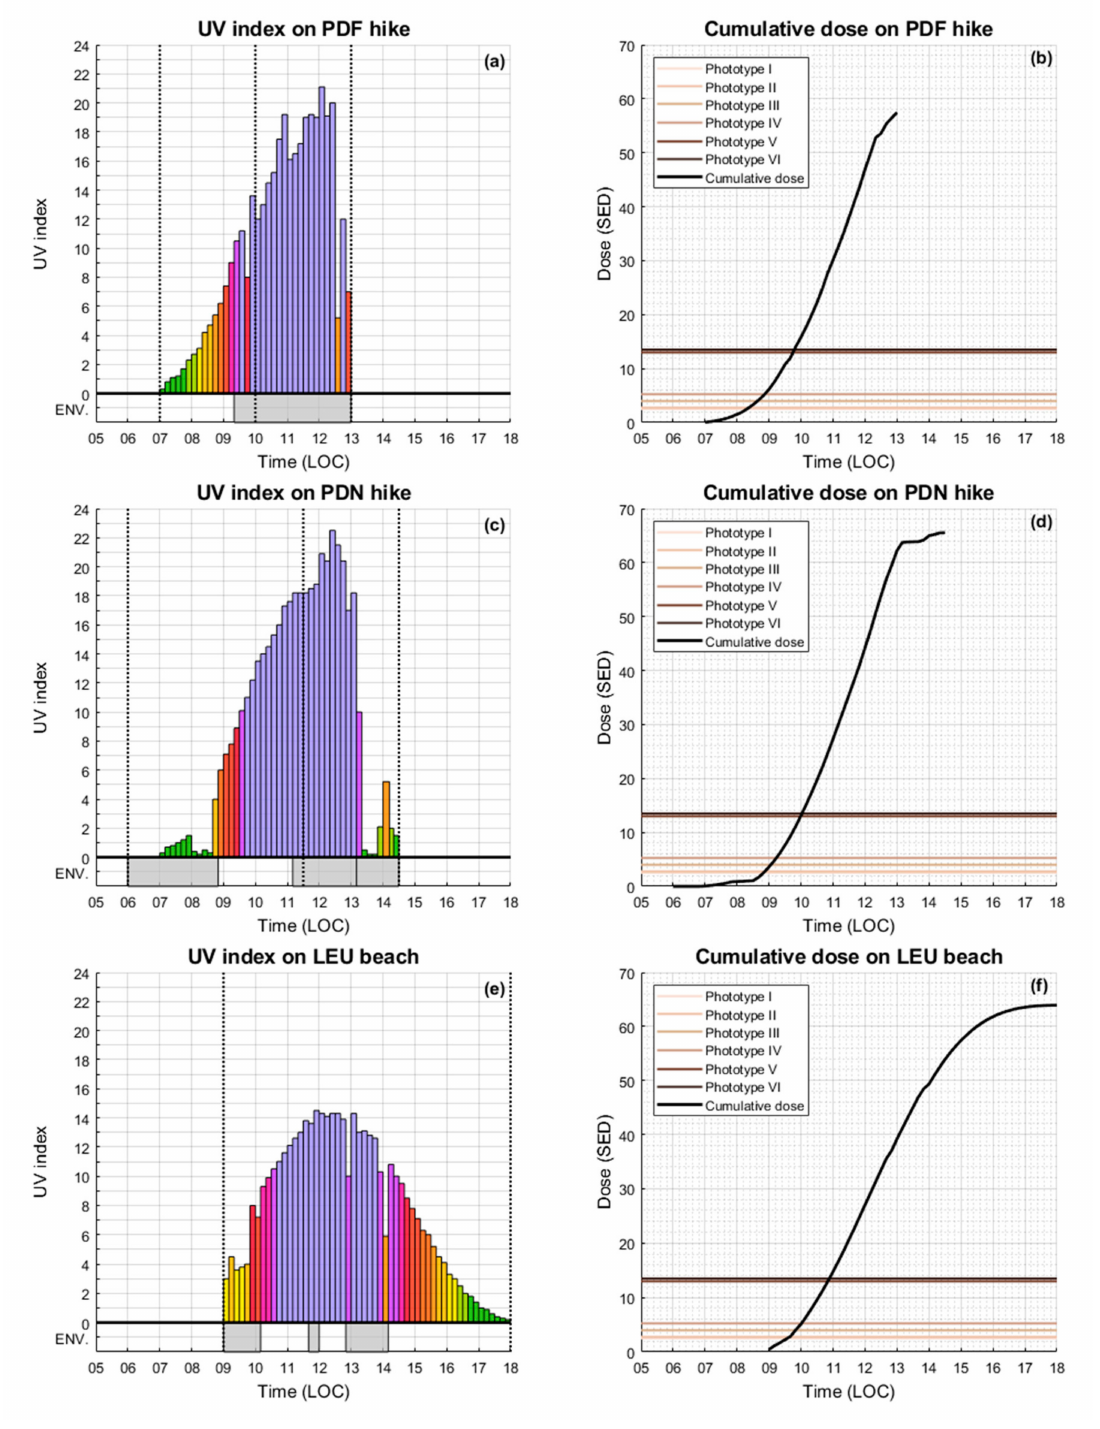
Figure 3. ( a , c , e ) show UVI recorded at PDF, PDN, and LEU, respectively. The colors of the histograms are similar to those used by the WHO, but with some variations within each color band to show more details. Vertical dotted lines show the beginning and the end of the activities. For PDF and PDN, a third vertical dotted line shows the U-turn point, between the ascending and descending part of the hikes. The grey surfaces, ENV., at the bottom of the figures show environmental e ff ects a ff ecting UVR, mainly cloud cover and shade. Cumulative UV doses at PDF, PDN, and LEU are shown in ( b , d , f ), respectively. The black curves on the right plots represent the cumulative exposure doses, while the superimposed horizontal lines show the threshold for one exposure dose to sunburn as a function of skin phototype (Table